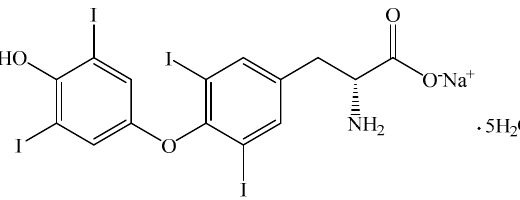
Figure 1. Structural formula of levothyroxine sodium salt pentahydrate (LTSS).